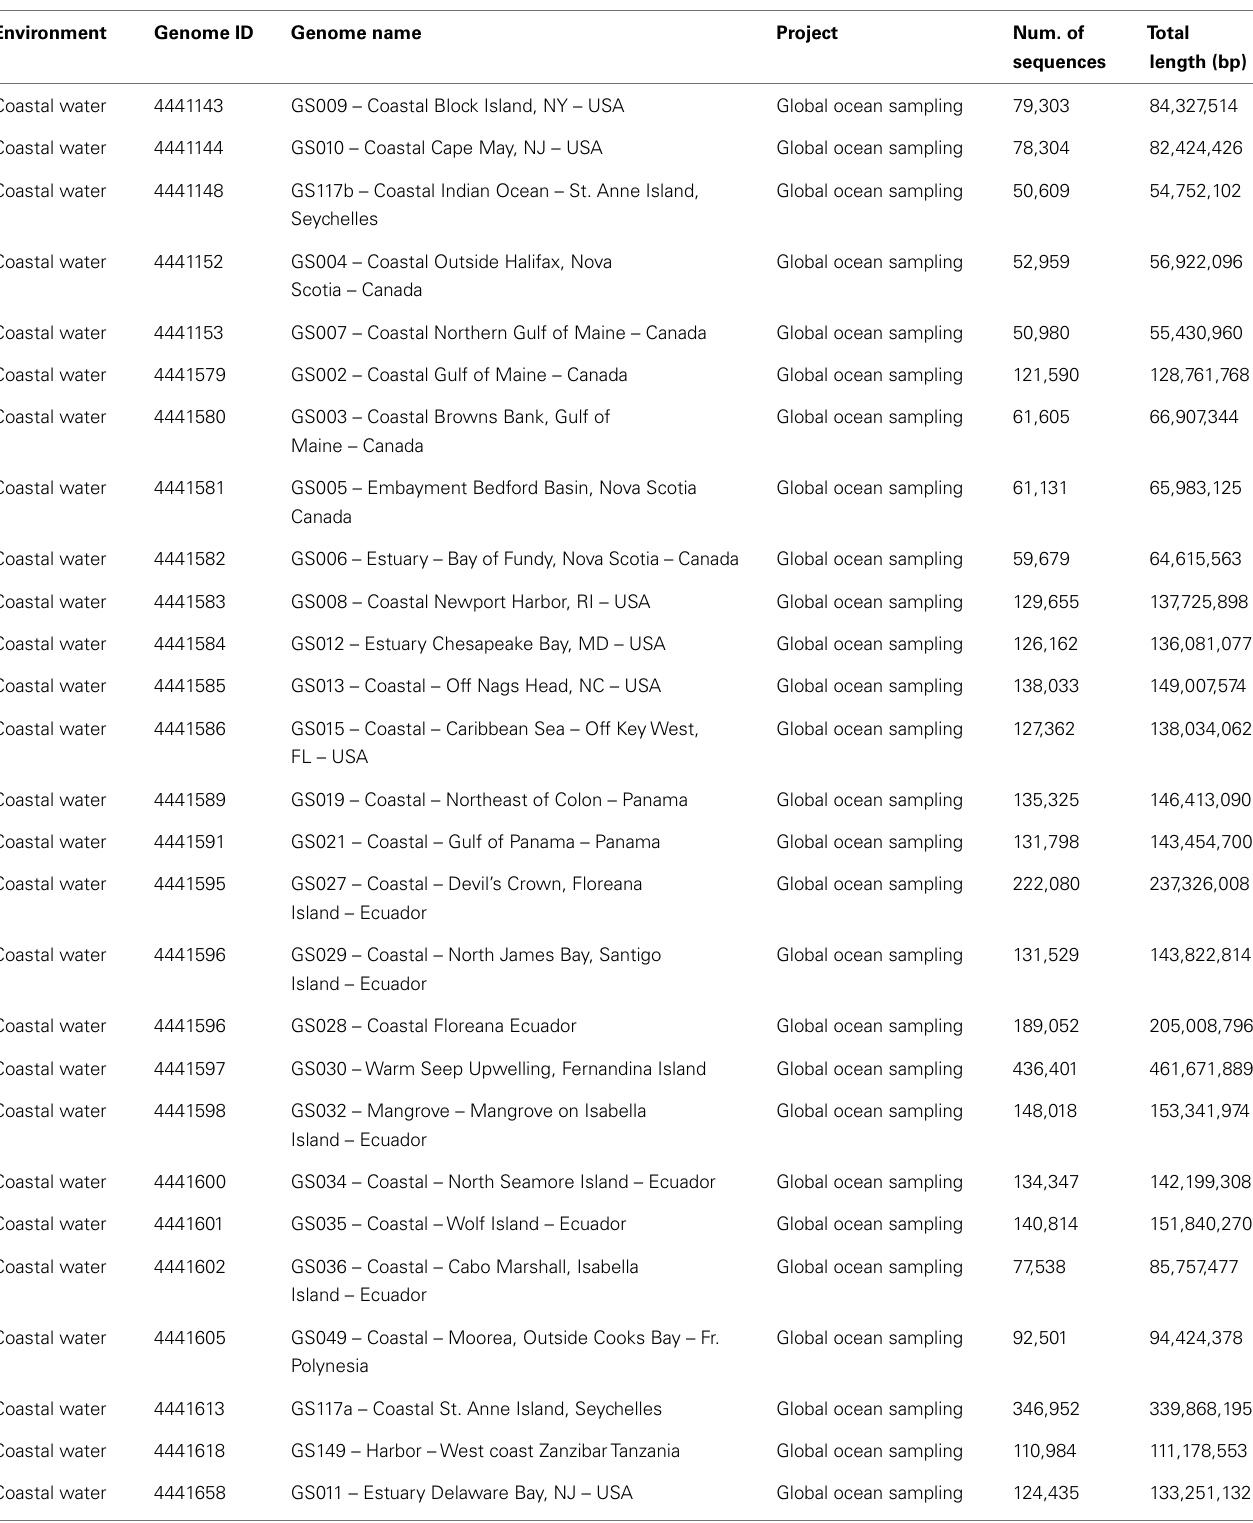
TableA1 | Metagenomes used in the